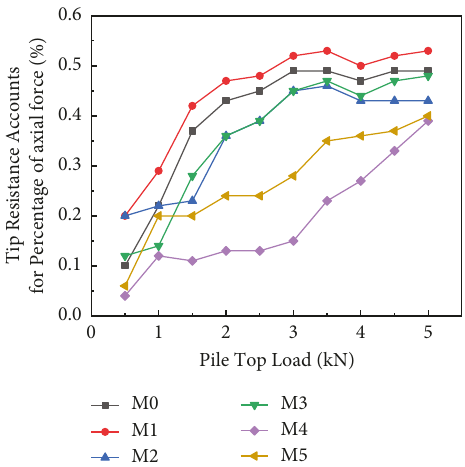
Figure 12: Relation curves between the tip resistance account for the percentage of axial force and pile top